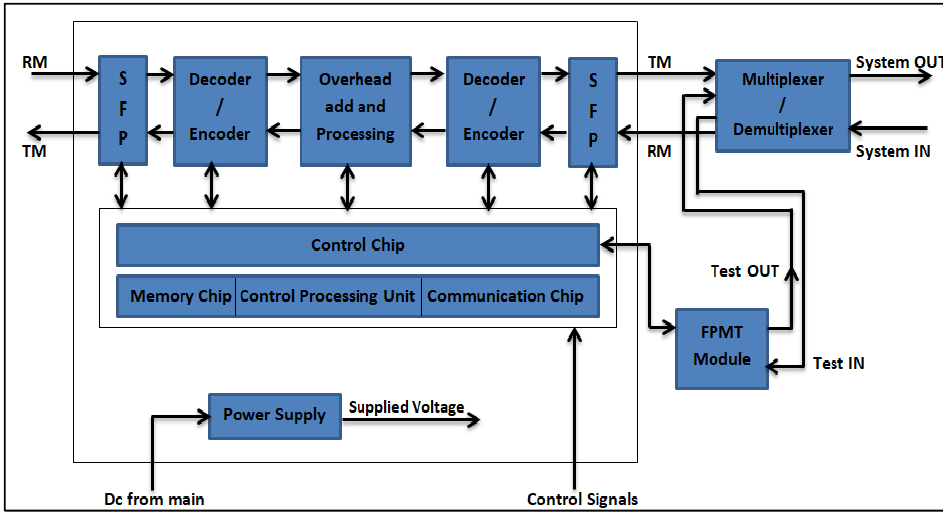
Figure 6. The OSC board block diagram after integrating the FPMT detection circuit.